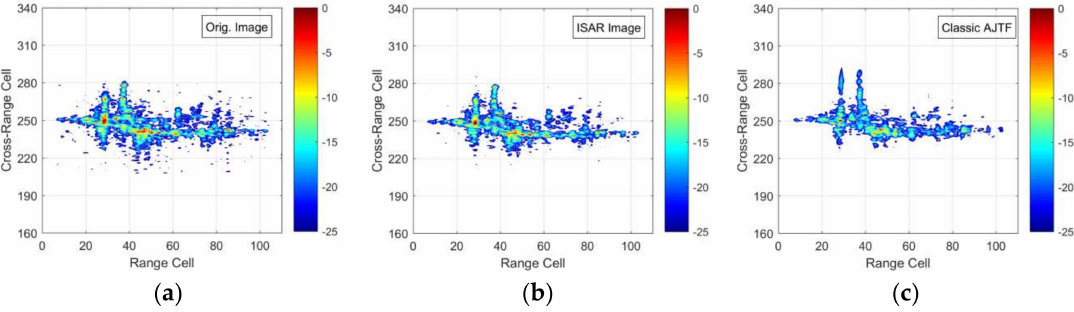
Figure 10. Imaging results by classical methods. ( a ) Direct imaging; ( b ) classical ISAR; and ( c ) classical